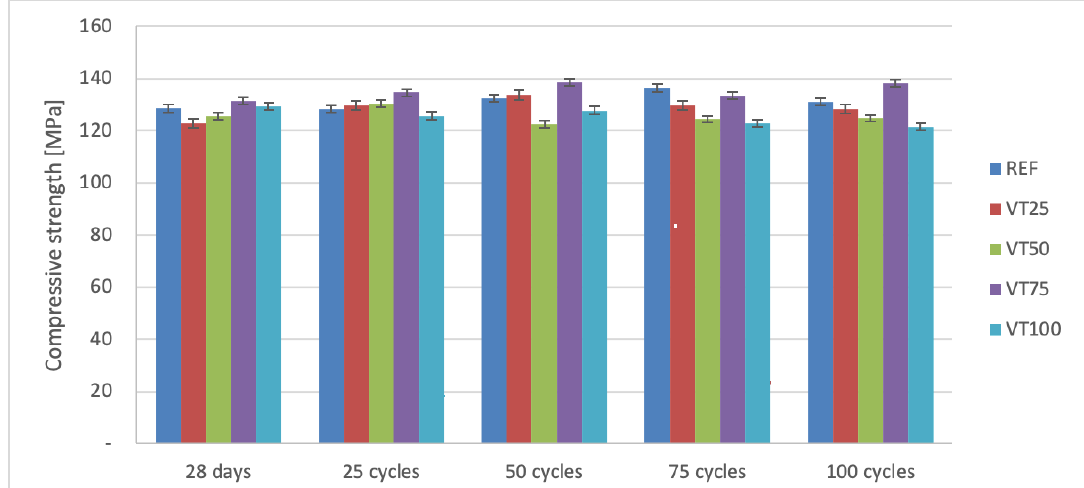
Figure 2. Compressive strength values after freeze-thaw resistance